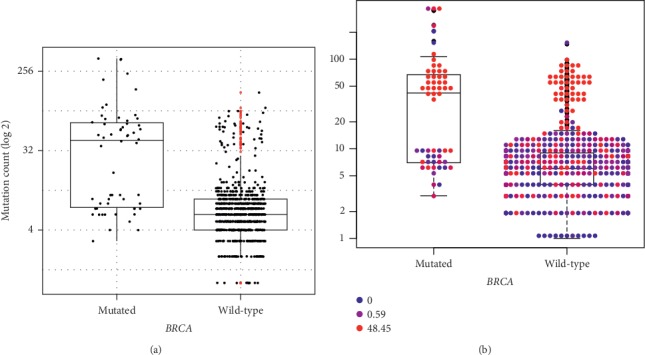
Relationship between BRCA-mutated vs. WT tumors and overall mutation count (a). Boxplot-swarmplot with the individual swarmplot points colored by MSI (b). MSI level score is calculated by MSIsensor (Niu et al. [25]) from blue (0) to red (48.45). Both plots are log-scaled.